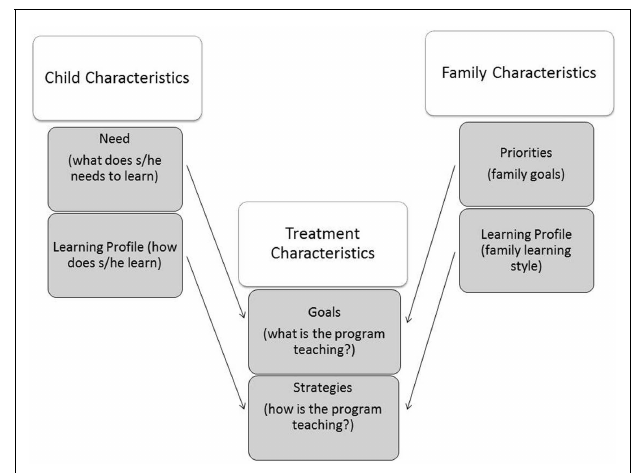
FIGURE 1 |Treatment goals should be selected on the basis of the child’s needs and family priorities. Treatment strategies should be selected on the basis of the child learning profile and the family’s learning